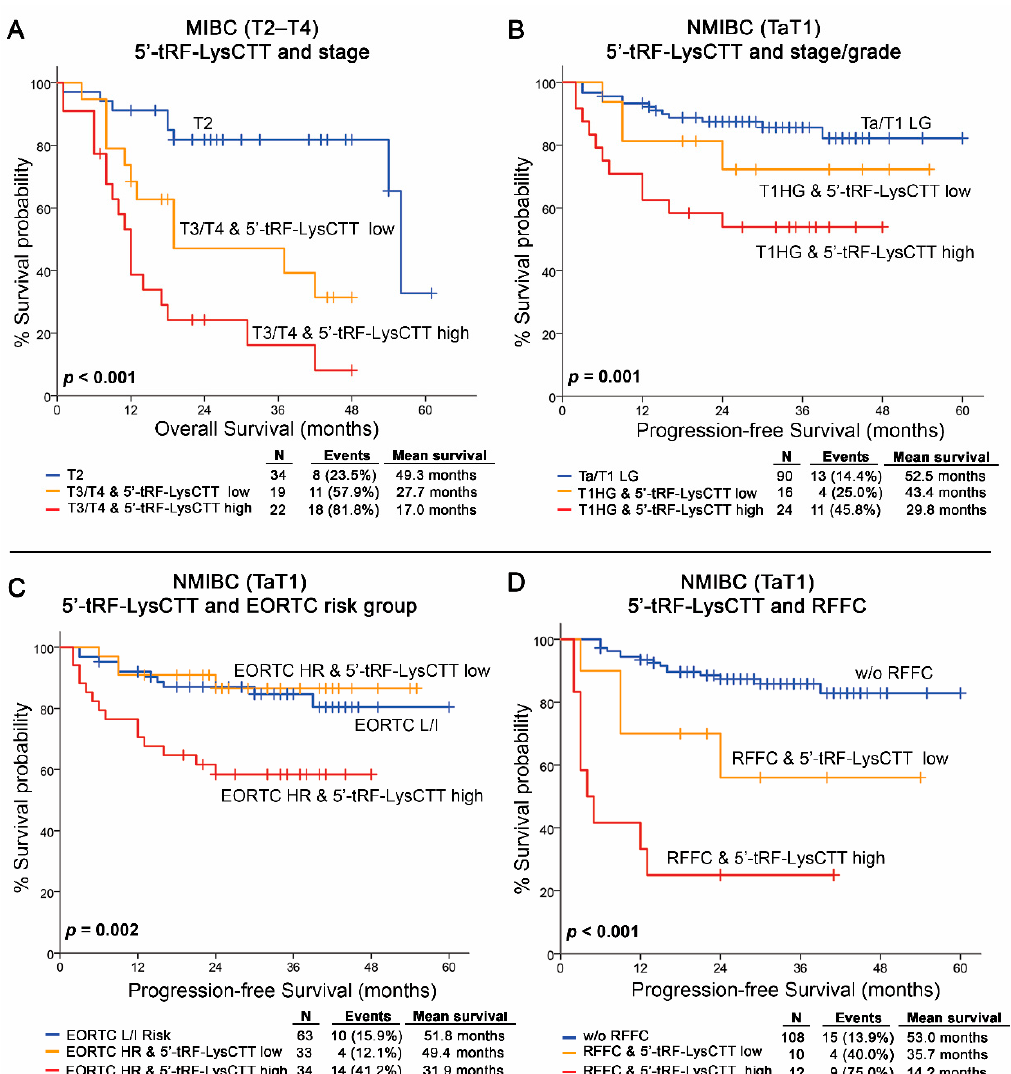
Figure 7. Evaluation of 5 ′ -tRF-LysCTT levels improves risk-stratification and results to superior clinical benefit in BlCa patients’ prognosis. ( A ) Kaplan–Meier survival curves for the overall survival (OS) of the MIBC (T2-T4) patients according to 5 ′ -tRF-LysCTT levels complied with tumors stage. ( B – D ) Kaplan–Meier survival curves for the progression-free survival (PFS) of the NMIBC (TaT1) patients according to 5 ′ -tRF-LysCTT levels complied with tumors stage/grade ( B ), EORTC risk-group ( C ) and recurrence at the first follow-up cystoscopy (RFFC; D). p -values calculated by log-rank test. 2.7. Decision Curve Analysis Revealed the Superior Clinical Net Benefit in Disease Prognosis by Multivariate Models Incorporating 5 (cid:48)